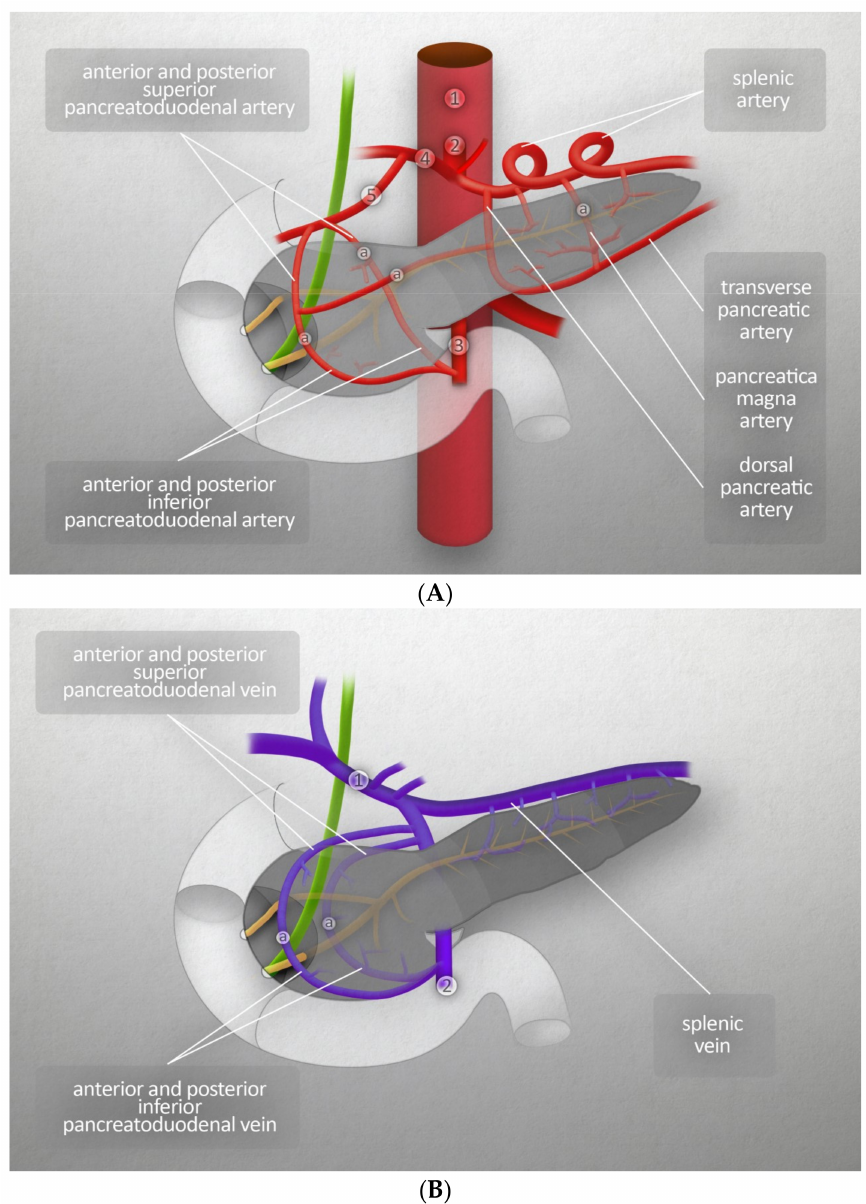
Figure 2. ( A ) Major blood vessels of the pancreas- arteries: (1) abdominal aorta, (2) celiac trunk, (3) superior mesenteric artery, (4) common hepatic artery, (5) gastroduodenal artery, (a) anastomotic branch. ( B ) Major blood vessels of the pancreas-veins: (1) hepatic portal vein, (2) superior mesenteric vein, (a) anastomotic